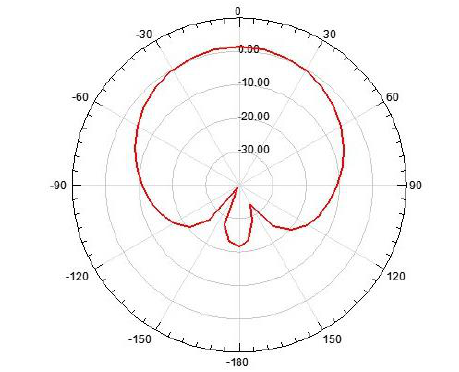
Fig.1.4 2D Radiation Pattern of the Antenna 1